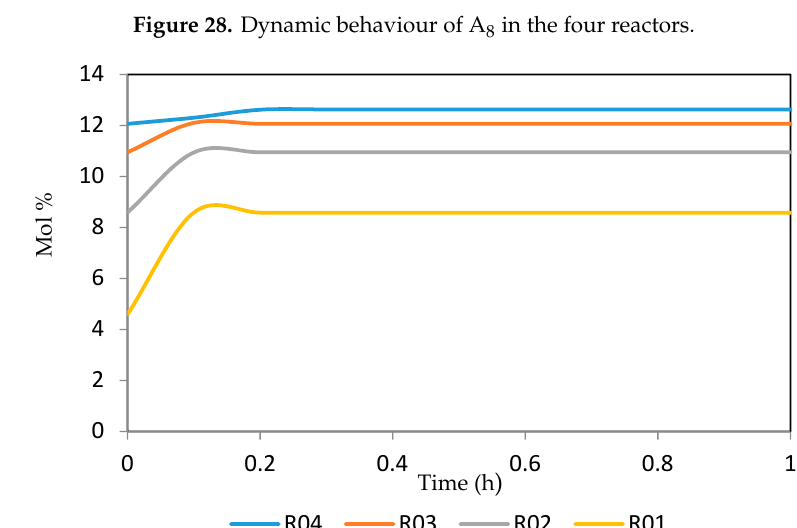
Figure 29. Dynamic behaviour of A 9 in the four reactors.